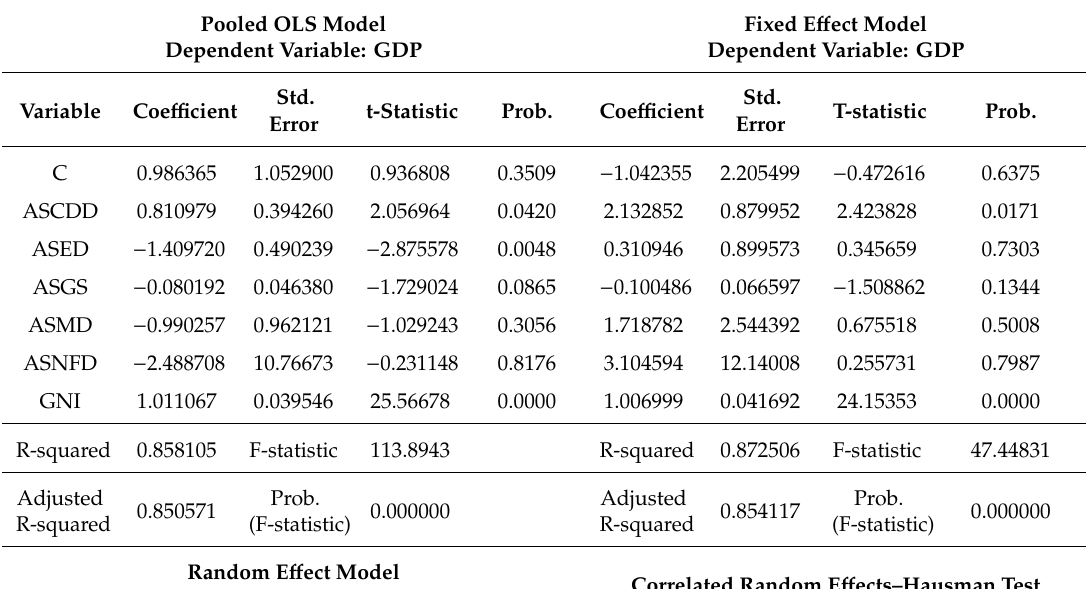
Table 4. Pooled OLS, Fixed e ff ect, Random e ff ect and Hausman